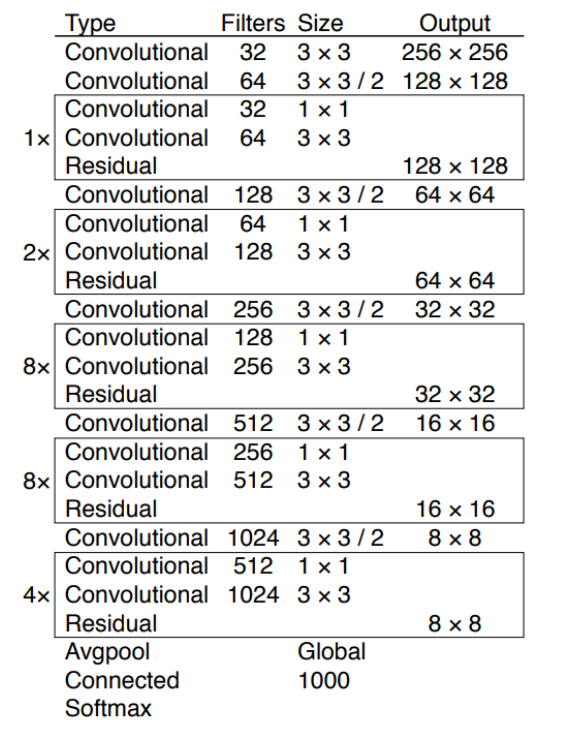
Figure 2. Darknet53 architecture that is used as YOLOv3’s backbone